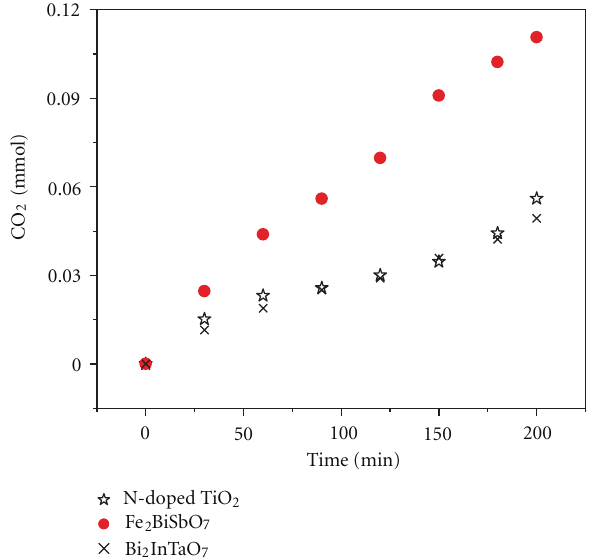
Figure 5: CO 2 production kinetics during the photocatalytic degradation of methylene blue with Fe 2 BiSbO 7 , Bi 2 InTaO 7 , or N- doped TiO 2 as catalyst under visible light